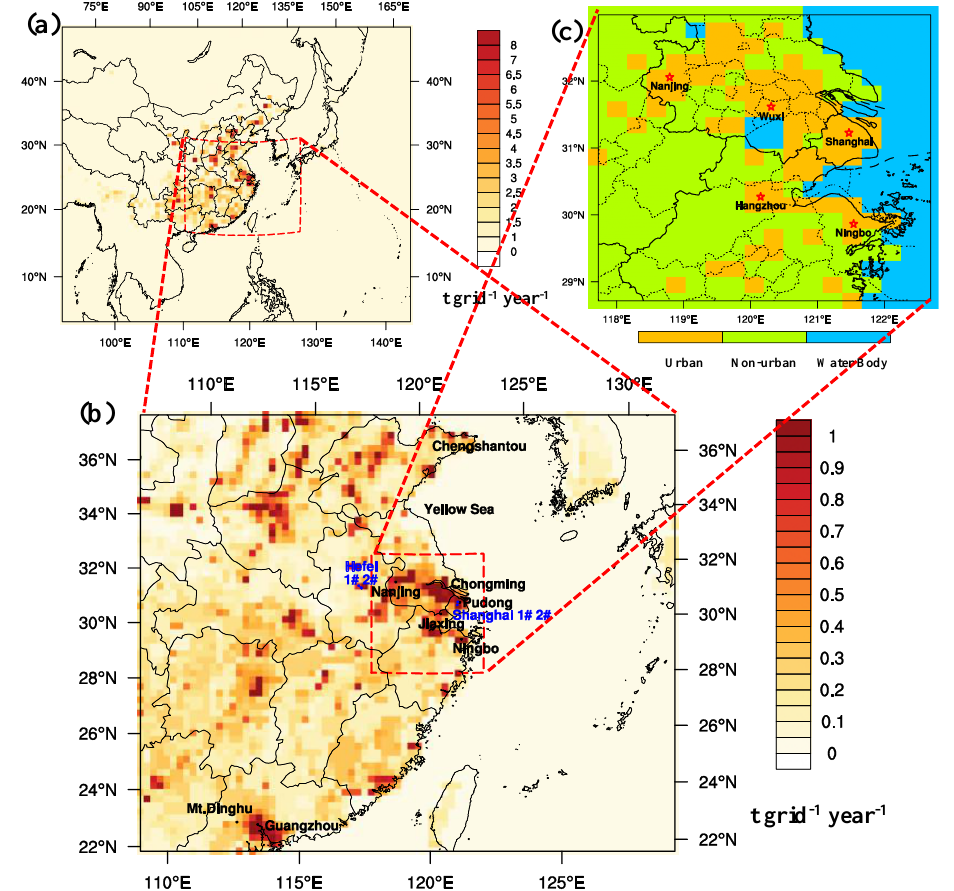
Figure 1. Model domains: (a) domain 1 with annual total mercury emission, (b) domain 2 with annual total mercury emission, and (c) Yangtze River delta (YRD) area with land use